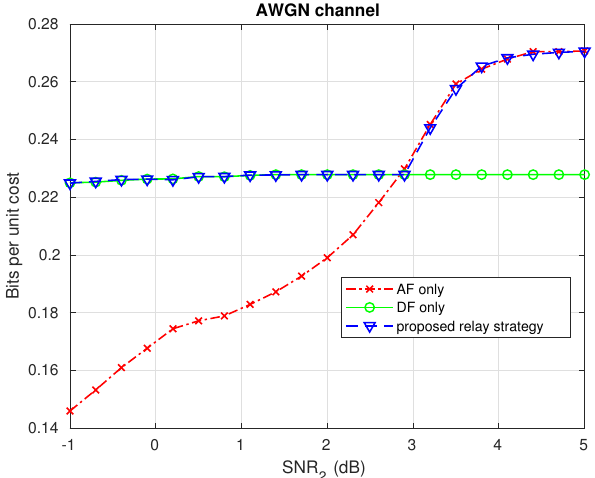
Figure 8. Average throughput of different relay strategies in AWGN